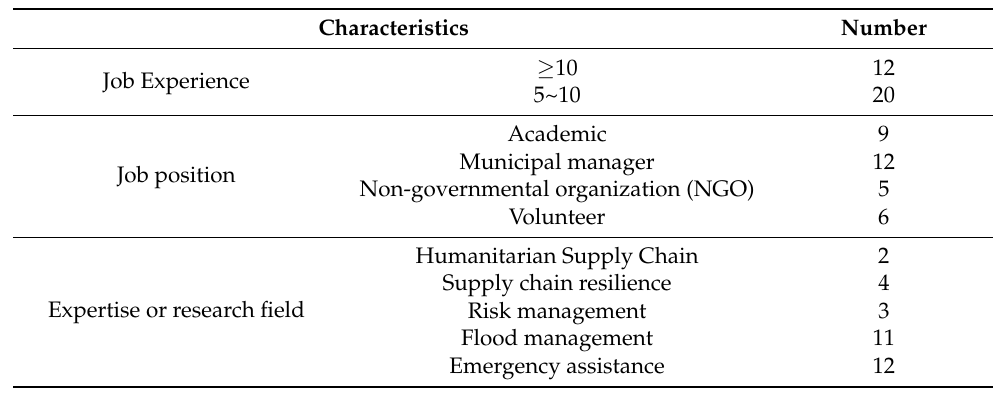
Figure 2. Map of the study area.